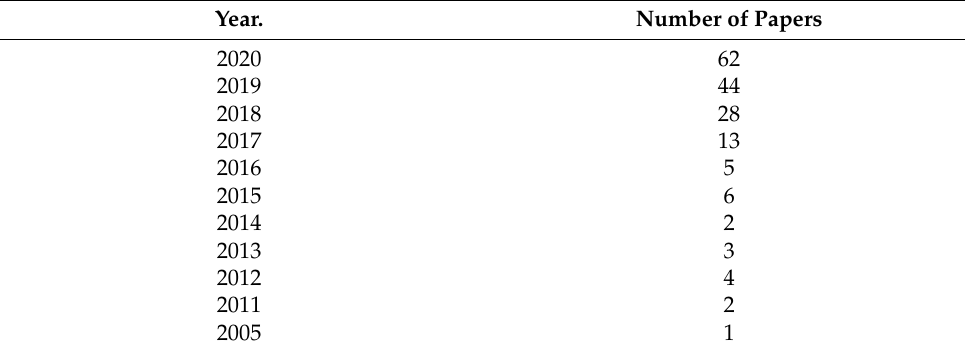
Table 1. The current state of publishing (line 154).